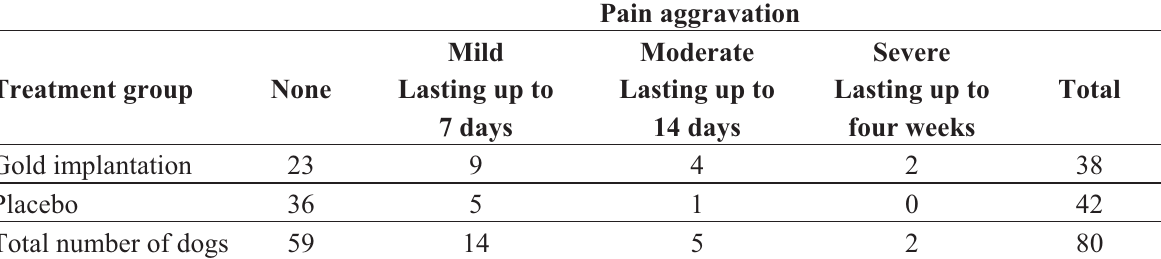
Table 3. Pain aggravation in dogs with hip dysplasia after treatment in gold implantation group versus placebo group of dogs with blood and/or synovia leakage from the implantation needles during insertion of gold beads around the hips of 38 dogs with hip